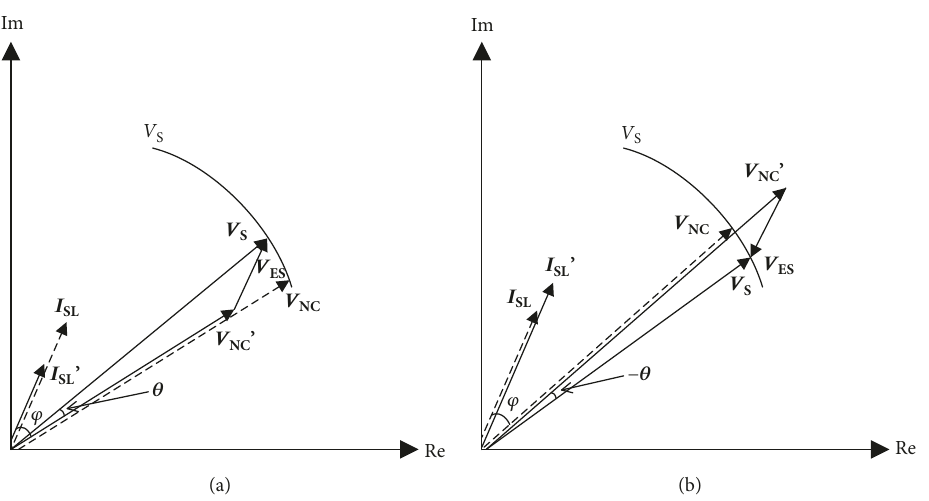
Figure 6: The vector diagram when ES is applied to restrain the demand side power fluctuation while noncritical load is resistive-capacitive. (a) Resistive mode. (b) Negative resistive mode.